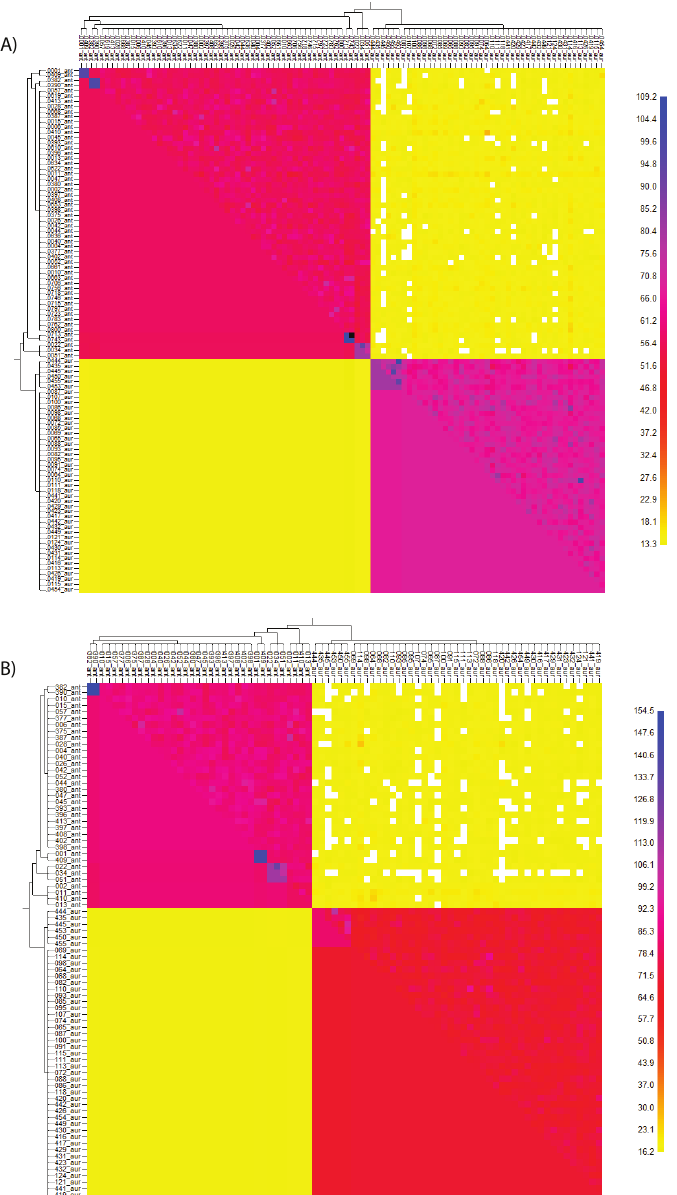
Figure 4. Clustered fineRADstructure co-ancestry matrix. A Full dataset including U. antarctica col- lected on the Antarctic Peninsula in addition to U. antarctica and U. aurantiacoatra collected on King George Island and Elephant Island B Reduced dataset with all U. antarctica and U. aurantiacoatra col- lected on King George Island and Elephant Island. Two major clades are corresponding to the two species U. antarctica (top-left) and U. aurantiacoatra (bottom-right). The top and left trees were calculated from the co-ancestry matrix to sort the individuals by their population structure. The matrix is diagonally split into the top-right half showing raw data and the bottom-left half displaying aggregated